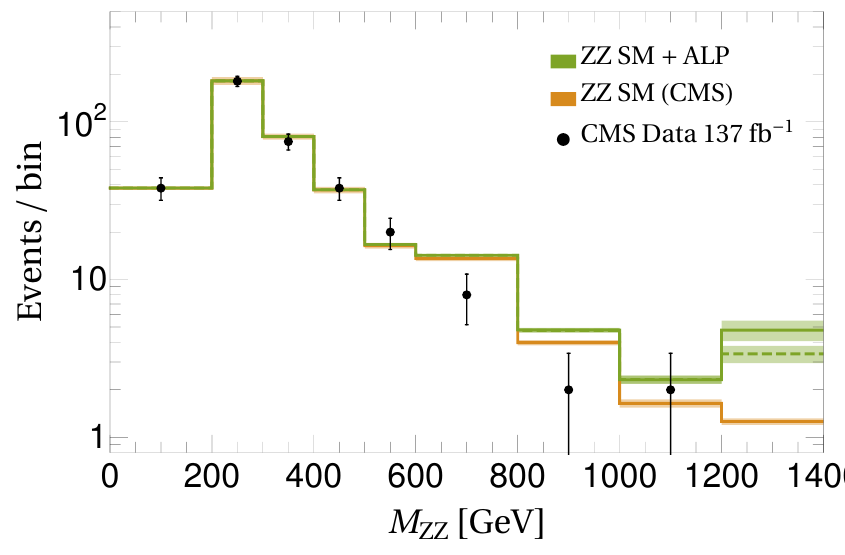
Figure 7 . M ZZ distribution for the pp → jjZZ → jj‘ + ‘ − ‘ + ‘ − channel. The data points and the total SM background (orange) are taken from the measurement in ref. [51]. The last bin contains the overflow events. The dashed and solid green lines show the total ALP EW VBS signal for c /f a = c /f a = 1 TeV − 1 with a cut of M ZZ < 2 TeV and 4 TeV , e B e W